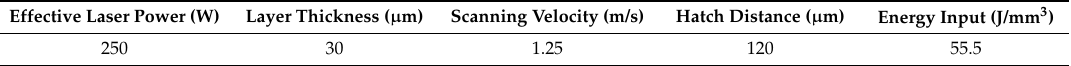
Table 1. Process parameters used in Selective Laser Melting (SLM) manufacturing of NiTi parts. Effective Laser Power